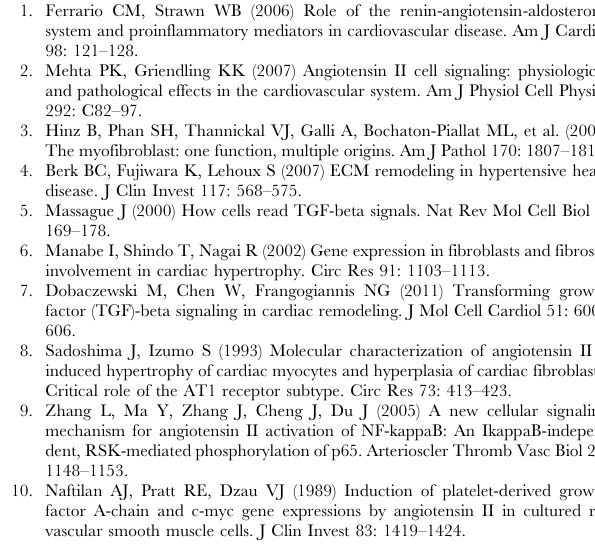
Figure S1 A–B, Klf expression in cardiomyocytes and VSMCs in response to Ang II infusion. Klf mRNA levels in cardiomyocytes (A) and VSMCs (B) after 2 hrs of stimulation with PBS control or Ang II (1 m mol/L). Klf8, Klf14, Klf16 and Klf17 were not detectable in cardiomyocytes. Klf1, Klf2, Klf 8, Klf 14 and Klf 17 were not detectable in VSMCs (n= 3). B, Data are the mean 6 SEM. *P , 0.05, vs. PBS control. C, a -SMA and p-Smad3 protein levels in Ang II-treated cardiac fibroblasts. Protein levels were assessed by Western blot after Ang II treatment for 0, 12, 24 or 48 hrs. GAPDH was a loading control. Figure S2 Adenovirus-mediated expression of the VP- Klf4 in cardiac fibroblasts. A, construction of the tetracycline- regulated adenovirus expressing VP-Klf4. B, cardiac fibroblasts were infected with different titers of Ad-Klf4 and Ad-tTA in the presence or absence of tetracycline (0.1 m g/ml). After 24 hrs, Klf4 protein levels were assessed by Western blot and showed a titer- dependent increase.